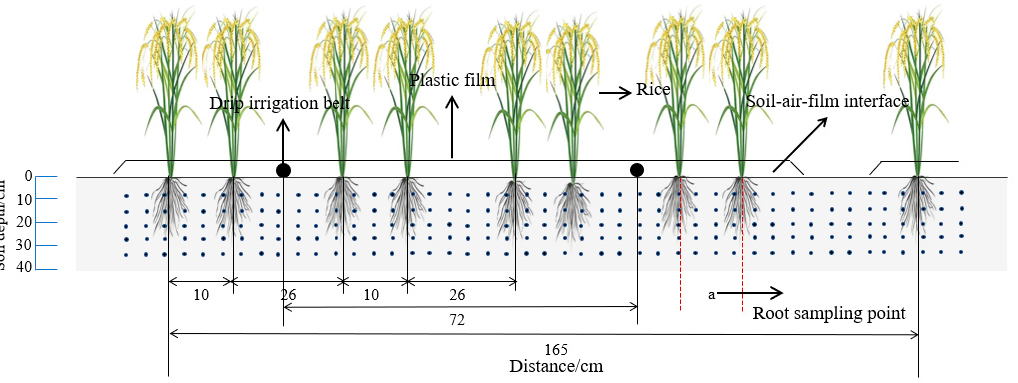
Figure 2. Rice planting pa tt ern and root sampling schematic diagram under mulched drip irrigation.